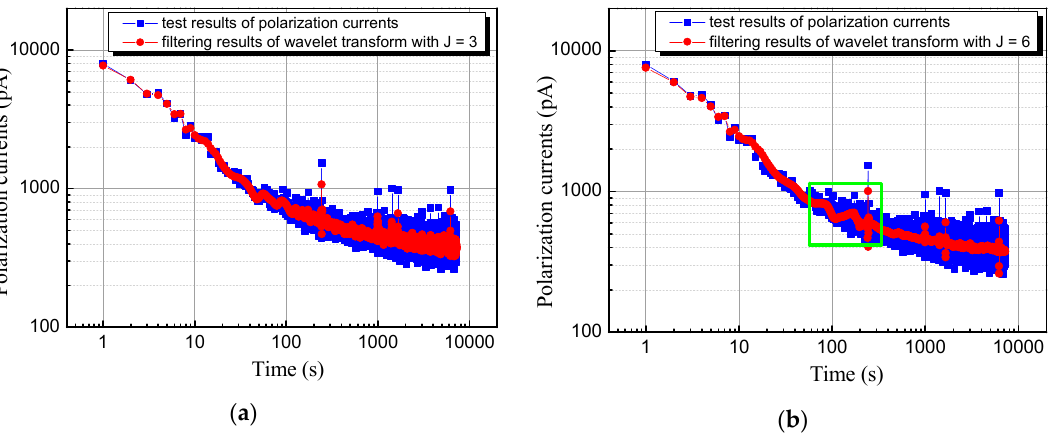
Figure 6. The effect diagram of wavelet transform filtering with different decomposition levels: ( a ) Figure 6. The e ff ect diagram of wavelet transform filtering with di ff erent decomposition levels: